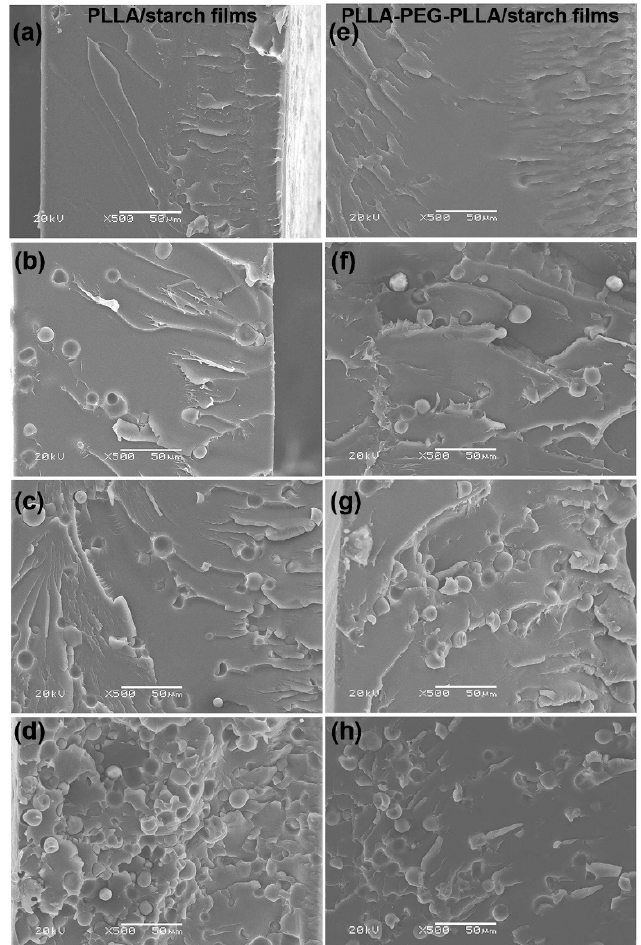
Figure 6. SEM images of cryogenically fractured surfaces of ( a ) pure PLLA film and PLLA/starch films with blend ratios of ( b ) 95/5, ( c ) 90/10 and ( d ) 80/20 ( w/w ), as well as ( e ) pure PLLA-PEG-PLLA film and PLLA-PEG-PLLA/starch films with blend ratios of ( f ) 95/5, ( g ) 90/10 and ( h ) 80/20 ( w/w ) (all bar scales = 50 µm).